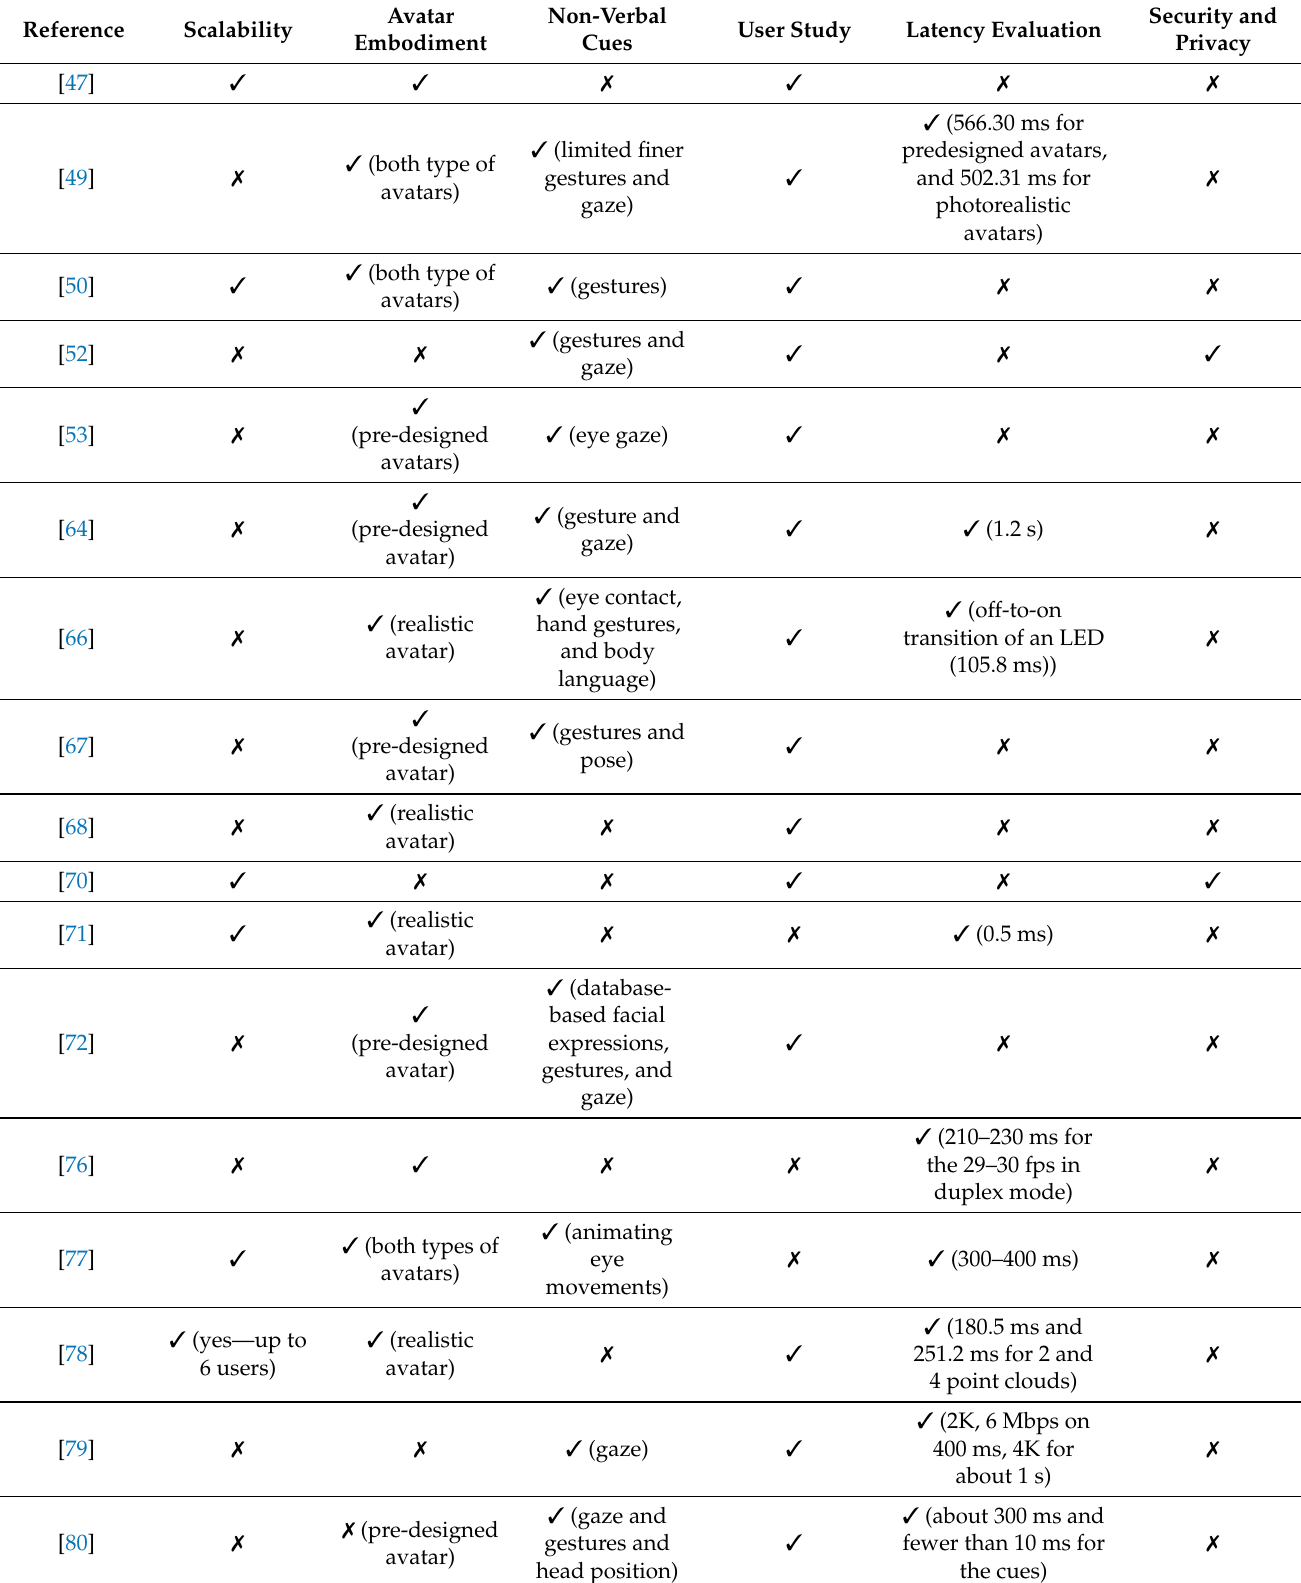
Table 7. HTC systems reviewed according to system scalability, avatar embodiment and non-verbal cues, system evaluation, and security and privacy